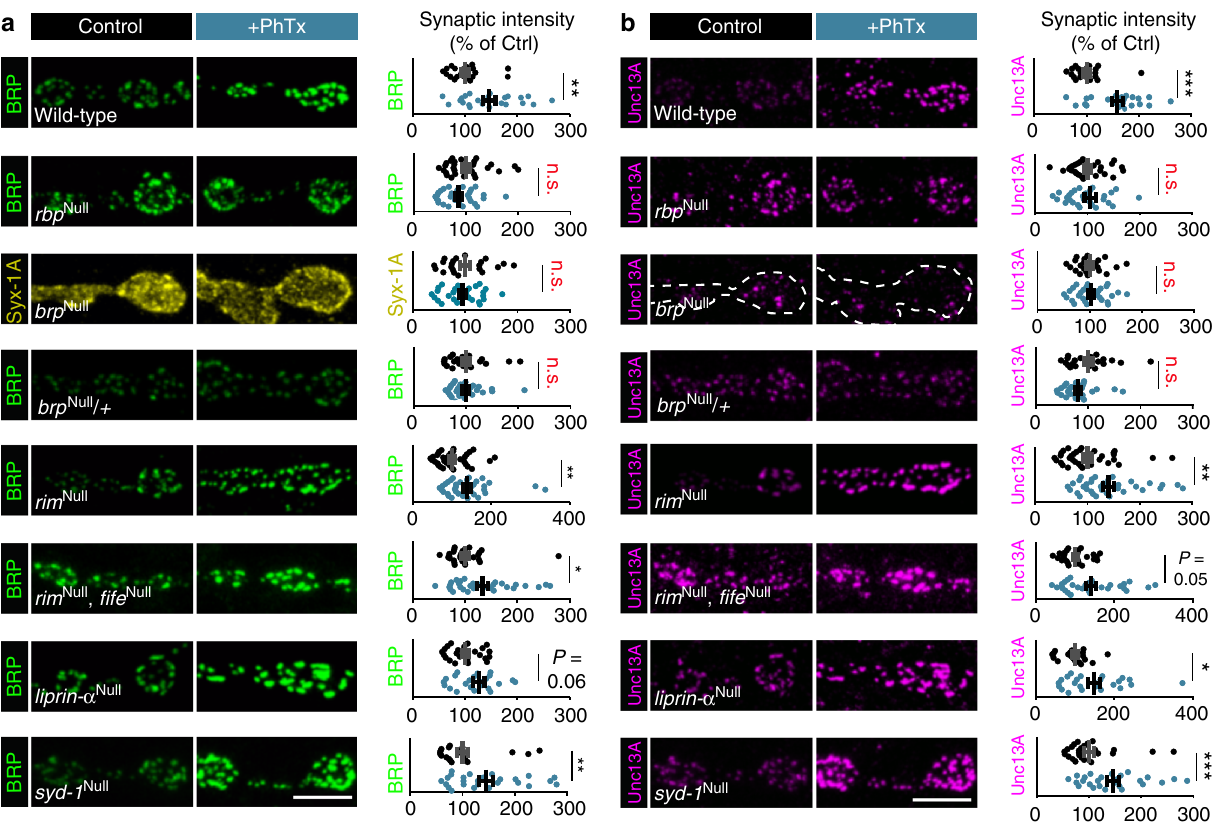
Fig. 4 Rapid AZ-remodeling during PHP requires BRP and RBP. a , b Confocal images and quanti fi cation of synaptic intensities of muscle 4 NMJs of abdominal segment 2 – 4 from third instar larvae at wild-type, rbp Null , brp Null , brp Null / + , rim Null , rim Null / fi fe Null , liprin- α Null , and syd1 Null NMJs labelled with the indicated antibodies without (control; black) and with 10 min PhTx ( + PhTx; blue) treatment. For wild-type, images and data were adapted and replotted from Fig. 1. Please note, although wild-type controls were performed in parallel to every mutant genotype to check for functional AZ-remodeling upon PhTx-treatment in each set of experiments, we do not show all WT-control here due to space limitations. Therefore, AZ-protein levels should not be compared between genotypes. Source data as exact normalized and raw values (also of additional Wild-type controls for genotypes where PhTx-treatment failed to induce AZ-remodeling), detailed statistics including sample sizes and P values are provided in the Source Data fi le. Scale bars: 5 µ m.